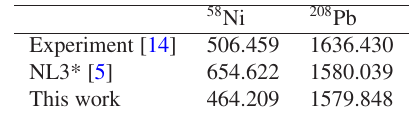
Table 2. The experimental and calculated ground-state BEs for 58 Ni and 208 Pb nuclei. Units are in